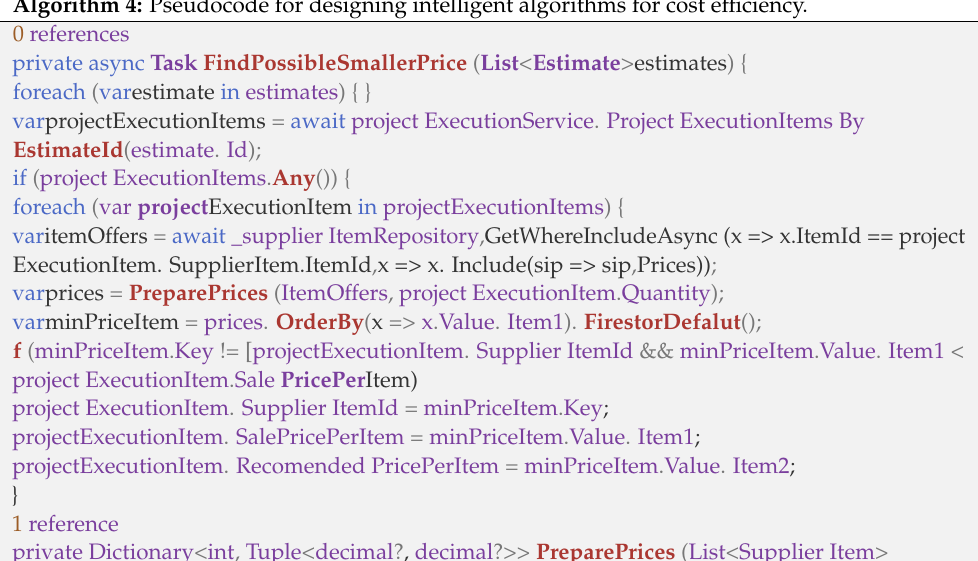
Algorithm 4: Pseudocode for designing intelligent algorithms for cost